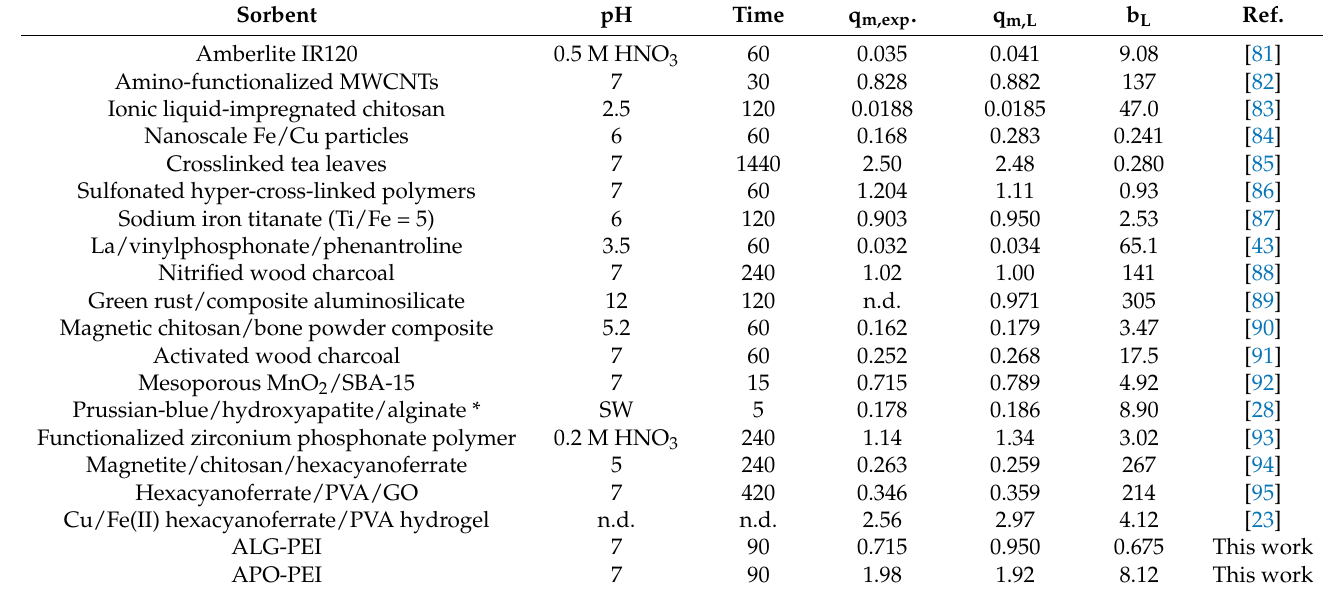
Figure A15. Cs(I) and Sr(II) sorption isotherms from binary solutions using ALG-PEI ( a ) and APO- PEI ( b ) sorbents (compared with isotherms from mono-component solutions—C 0 : 0.07–6.11 mmol Cs L − 1 and 0.11–9.23 mmol Sr L − 1 , with Sr/Cs molar ratio ≈ 1.5; pH 0 : 7; SD: 0.67 g L − 1 ; v: 210 rpm; T: 21 ± 1 °C). Table A5. Comparison of Cs(I) sorption properties with alternative sorbents.